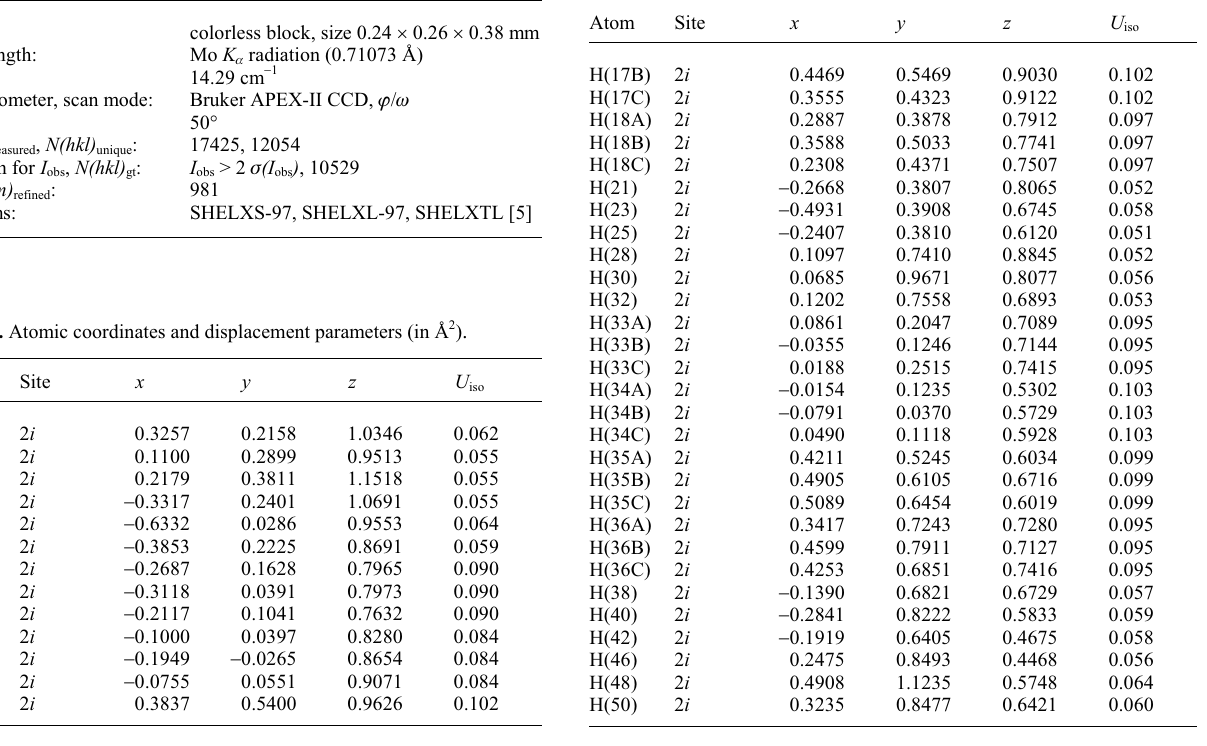
Table 1. Data collection and